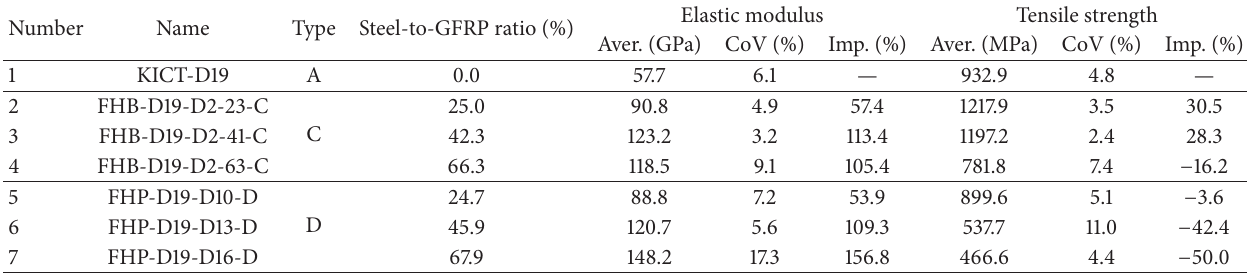
Table 5: Test results for D19 FRP Hybrid Bar.